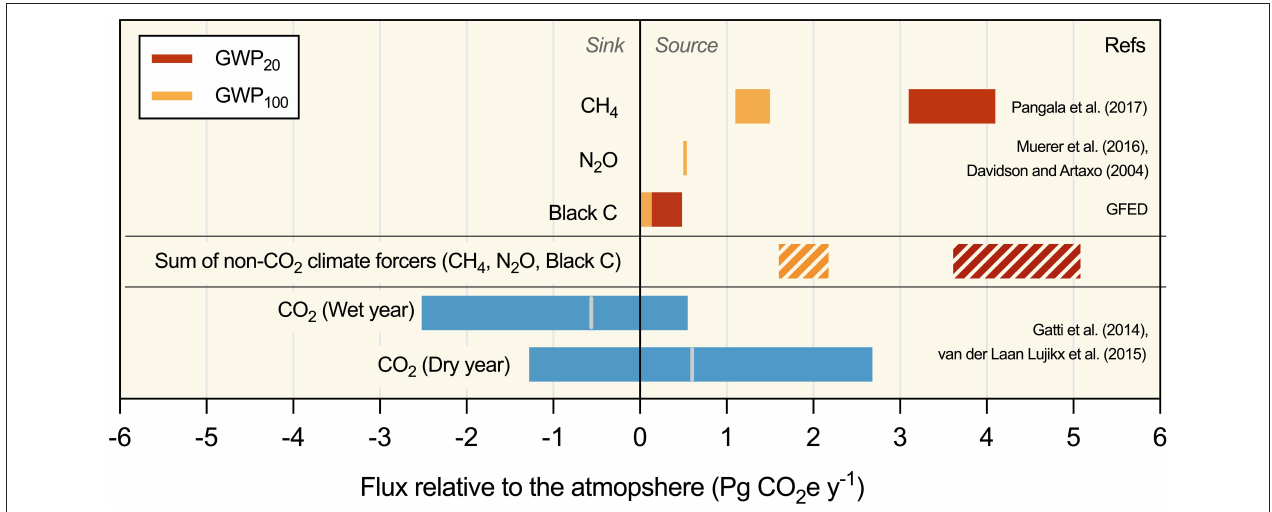
FIGURE 2 | Summary of annual fluxes for primary climate-forcing agents in the Amazon Basin, in Pg CO 2 -equivalent at two global warming potential (GWP) time horizons (20 and 100 years). For CO 2 , gray lines indicate means, plus the minimum and maximum uncertainty of five flux estimates for 2010 (anomalously dry year) and 2011 (wet year) that integrate both ecosystem productivity and biomass burning. These are the only years for which large-scale, inversion-based atmospheric C balance measurements for the basin are available. For CH 4 and black C, values are means ± 1 SD and for N 2 O values represent a range. GWP factors are from IPCC AR5 ( Myhre et al., 2013, 5) (CH 4 , N 2 O) or Bond et al. (2013; black C). There are no Basin-wide estimates of the total annual emission and GWP factors for biogenic volatile organic compounds (BVOCs), aerosols, and ozone. See Supplementary Information for flux